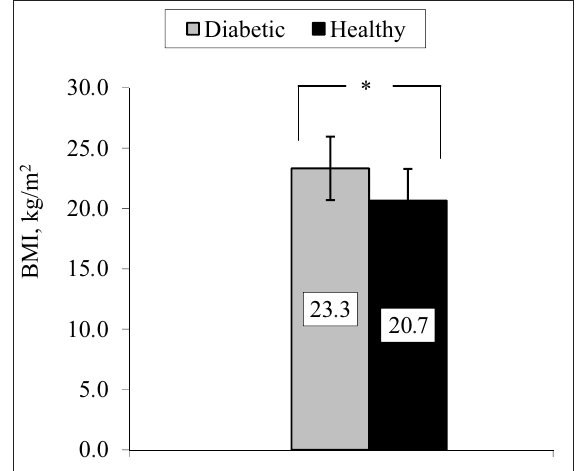
Figure 1. Body mass index (kg/m²) in diabetic and healthy women Note . * – p <